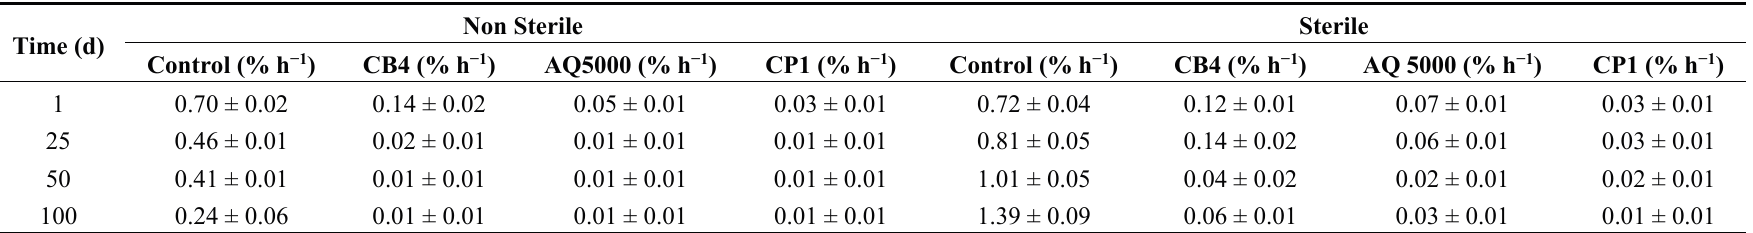
Table 2. Maximum rates of 14 C-phenanthrene mineralisation (% h − 1 ) in control and 1% AC-amended soils for both non-sterile and sterile soils. Values are mean ± standard error ( n = 3).